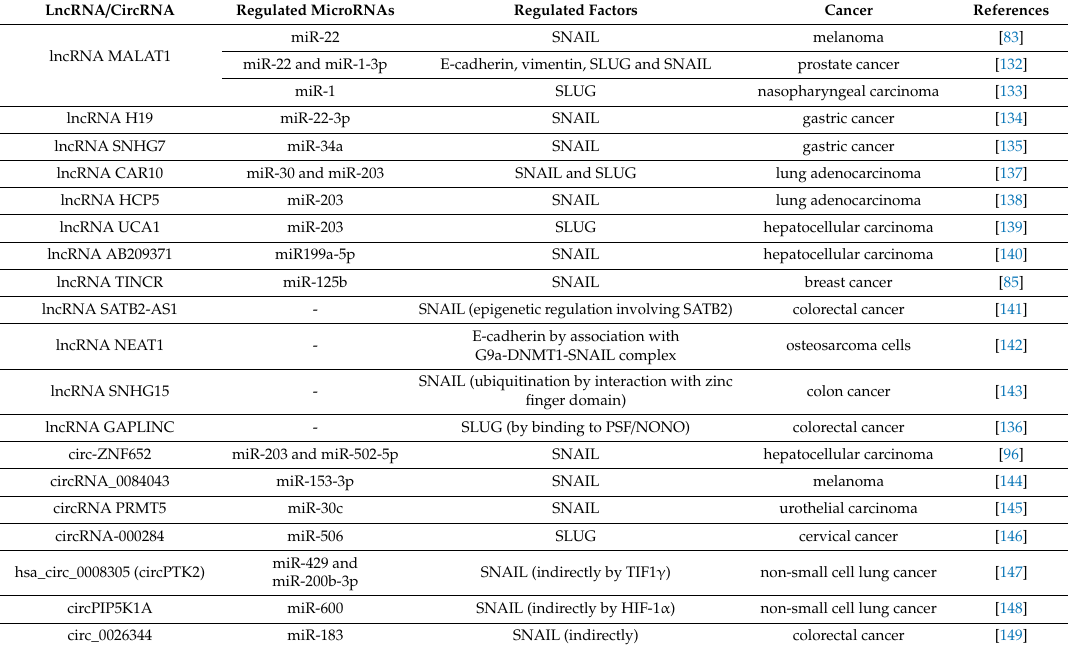
Table 4. Long non-coding RNAs regulating SNAIL and